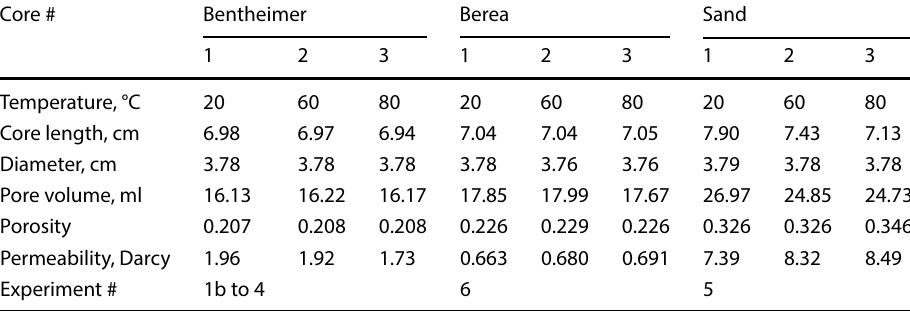
Table 3 Length, diameter, pore Core # Bentheimer Berea volume, porosity, and absolute permeability of the cores used in Experiment 1 to 6